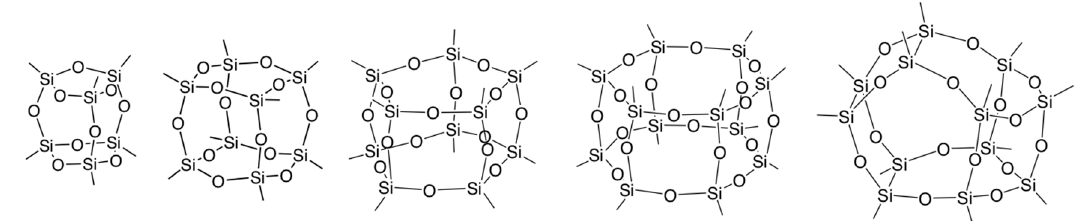
Figure 1. Typical structures of cage-type oligosiloxanes. The corner substituents are omitted for